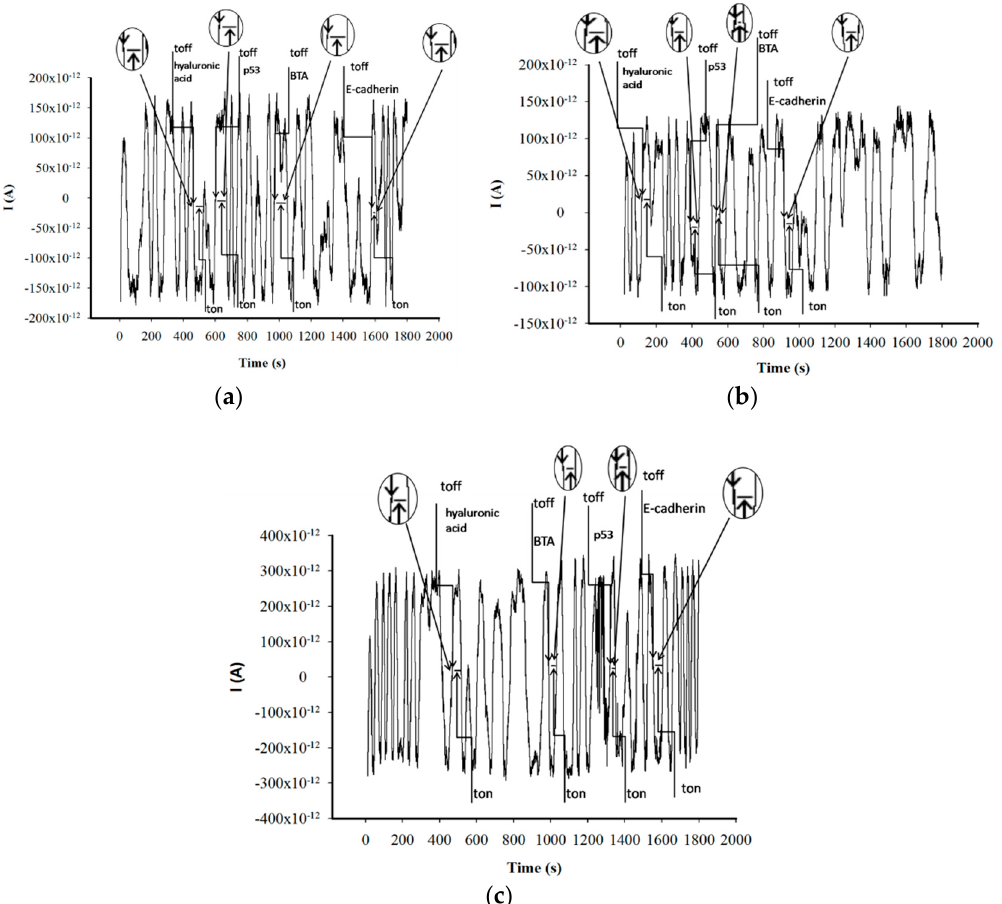
Figure 2. Pattern recognition of p53, E-cadherin, BTA, and hyaluronic acid in tissue samples using the stochastic needle sensor based on chitosan I/graphite ( a ), chitosan II/graphite ( b ), and chitosan III/graphite ( c ).